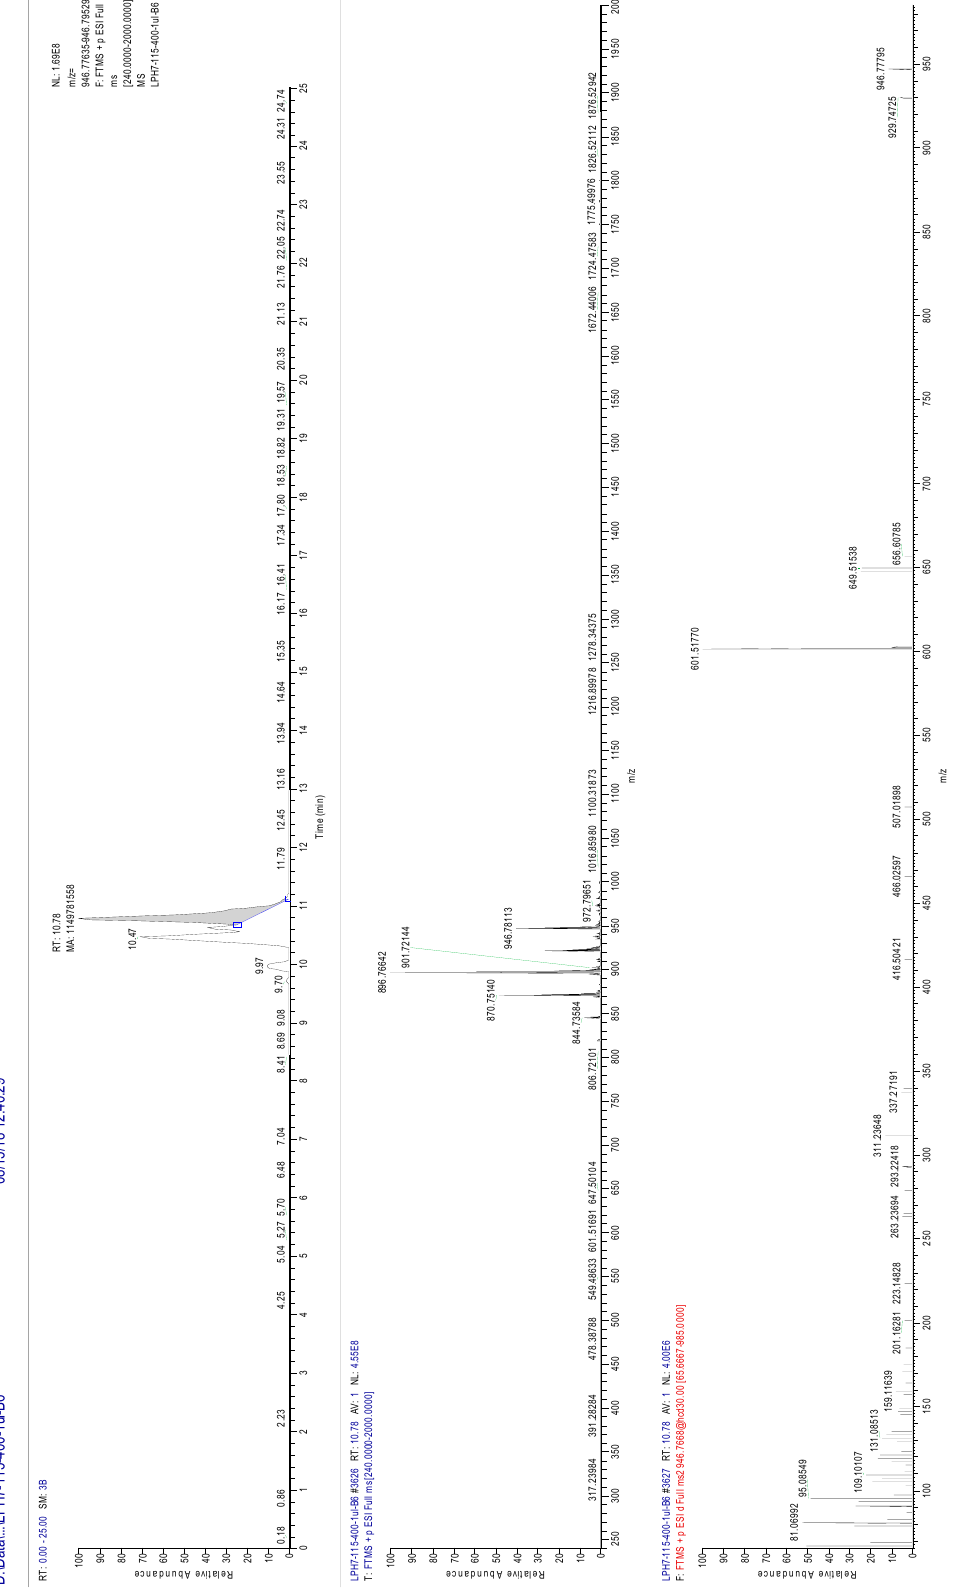
Figure 4. MS and MS/MS spectra of triglyceride (TG (18:1/18:2/22:6)). Figure 4. MS and MS / MS spectra of triglyceride (TG (18:1 / 18:2 /